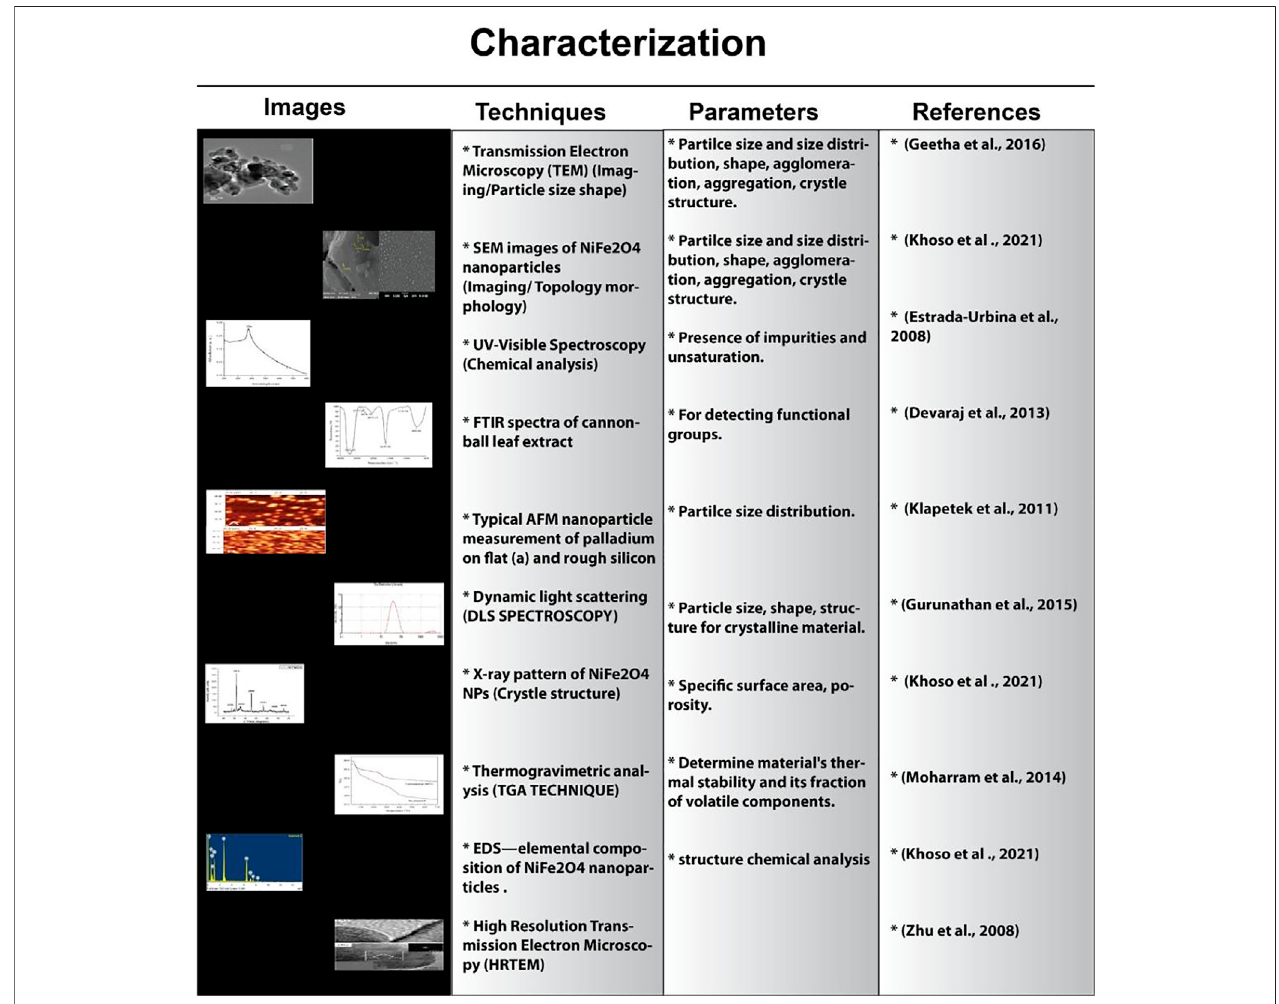
FIGURE 5 | Methodologies involved in the characterization of